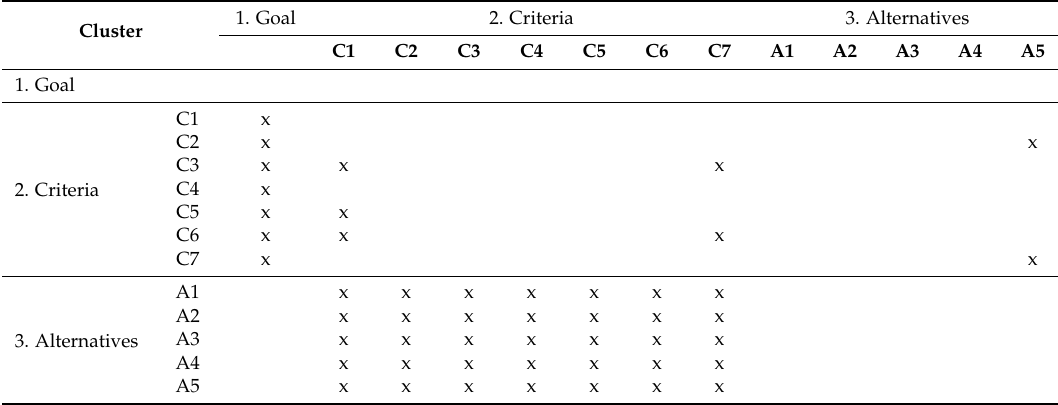
Table 5. Interaction between the elements of the decision-making process. 1. Goal 2. Criteria Cluster C1